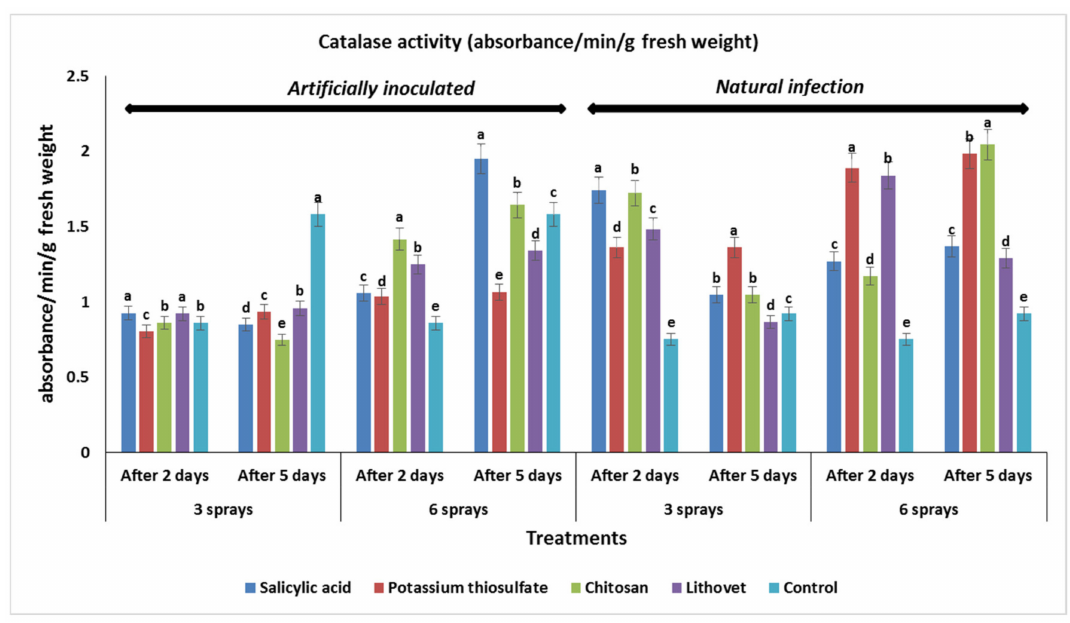
Figure 4. The e ff ect of tested chemicals as pre-harvest foliar application at 3 and 6 sprays on catalase activity in the treated tomato fruits, naturally and artificially infected with A. alternata , after di ff erent periods of incubation (absorbance / min / g fresh weight). Within each incubation period (after two or five days), the same letters indicate no significant di ff erence among treatments at ( p <